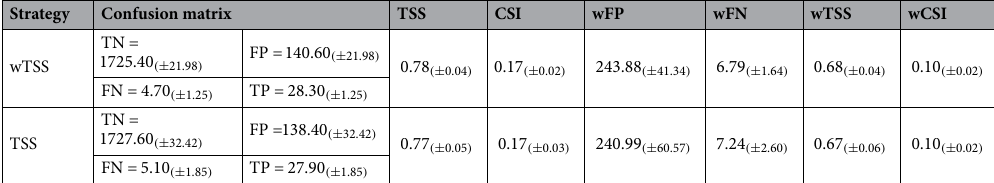
) j ∈ I (see (11)) where I is the set j ) j ∈ I by selecting the ones which j ) j ∈ I applied on a new input x . j